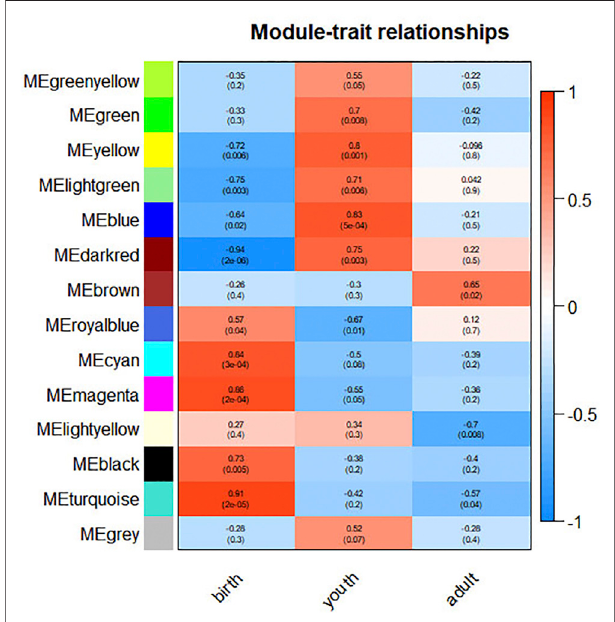
FIGURE2| Correlationbetweenmodulesanddifferentiationperiod.The color, ranging from blue through white to red, indicates negative to positive